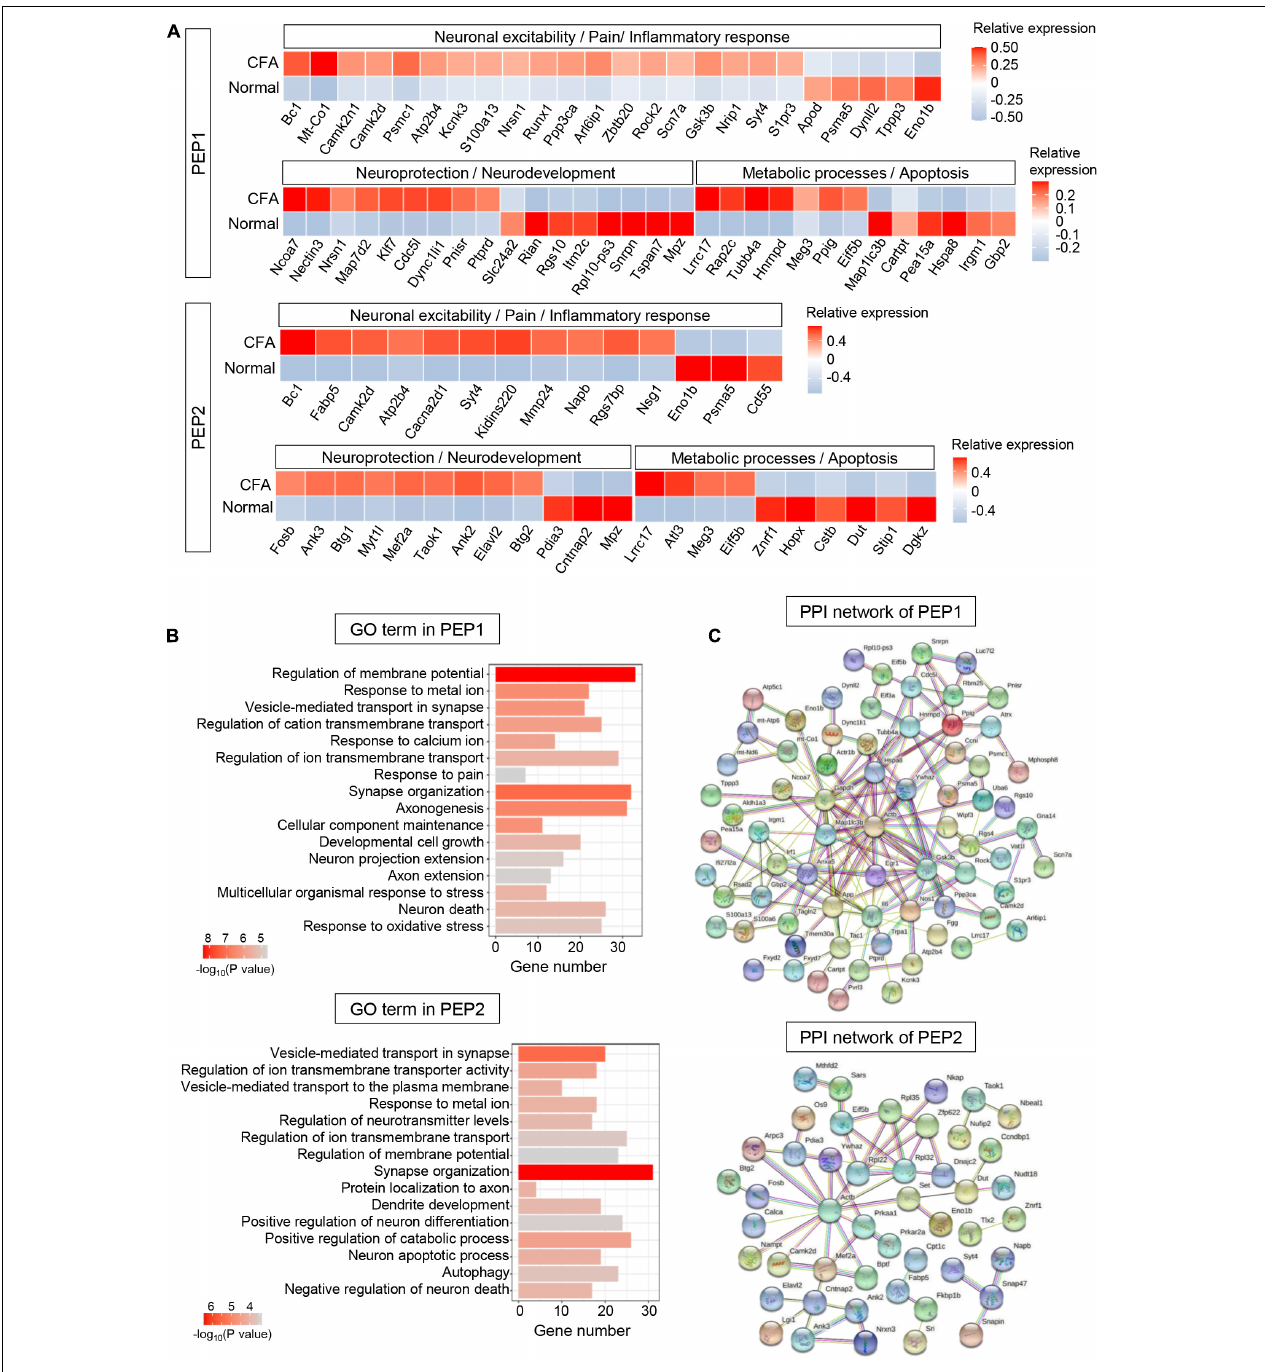
FIGURE 5 | Transcriptional responses of PEP neurons in mouse TG to orofacial inflammation revealed by scRNA-seq. (A) Heatmap of identified DEGs within PEP1 and PEP2 neurons under normal and orofacial inflammatory pain conditions. Red colors indicate upregulated expression level in the heatmap, while blue colors indicate downregulated expression level. (B) The enriched GO biological process terms of identified DEGs in PEP1 and PEP2 neurons following orofacial inflammation. The number of genes is plotted as the abscissa and enriched GO biological process term is plotted as the ordinate. The colors correspond to p -value range. (C) PPI network analysis of identified DEGs in PEP1 and PEP2 neurons following orofacial inflammation. The top hub genes in PEP1 are Actb (degree = 22), Il6 (degree = 17), Gsk3b (degree = 13), Hspa8 (degree = 12), Map1lc3b (degree = 10), and Nos1 (degree = 9), while top hub genes in PEP2 are Actb (degree = 13), Gsk3b (degree = 14), Rpl32 (degree = 7), Eif5b (degree = 4), and Ywhaz (degree = 4), etc. The line color indicates the type of interaction evidence, and line thickness indicates the strength of data support. Blue represents known interactions from curated databases, while purple represents experimentally determined interactions. Green, red, and royal blue represent gene neighborhood, gene fusions and gene co-occurrence, respectively. TG, trigeminal ganglion; scRNA-seq, single-cell RNA-sequencing; DEGs, differentially expressed genes; CFA, complete Freund’s adjuvant; PEP, peptidergic nociceptors; PPI, protein–protein interaction.